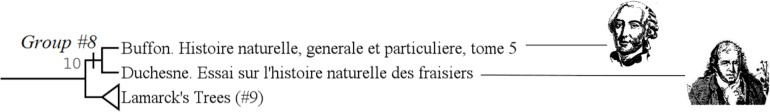
Subtree showing the group #8 (called “Limited-transformism trees”).